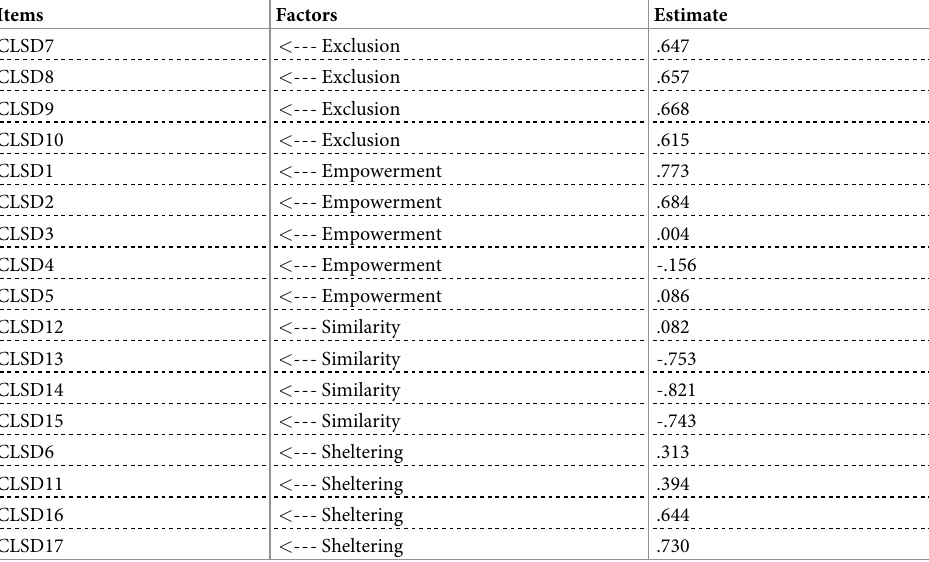
Table 1. Standardised regression weights of CLSD